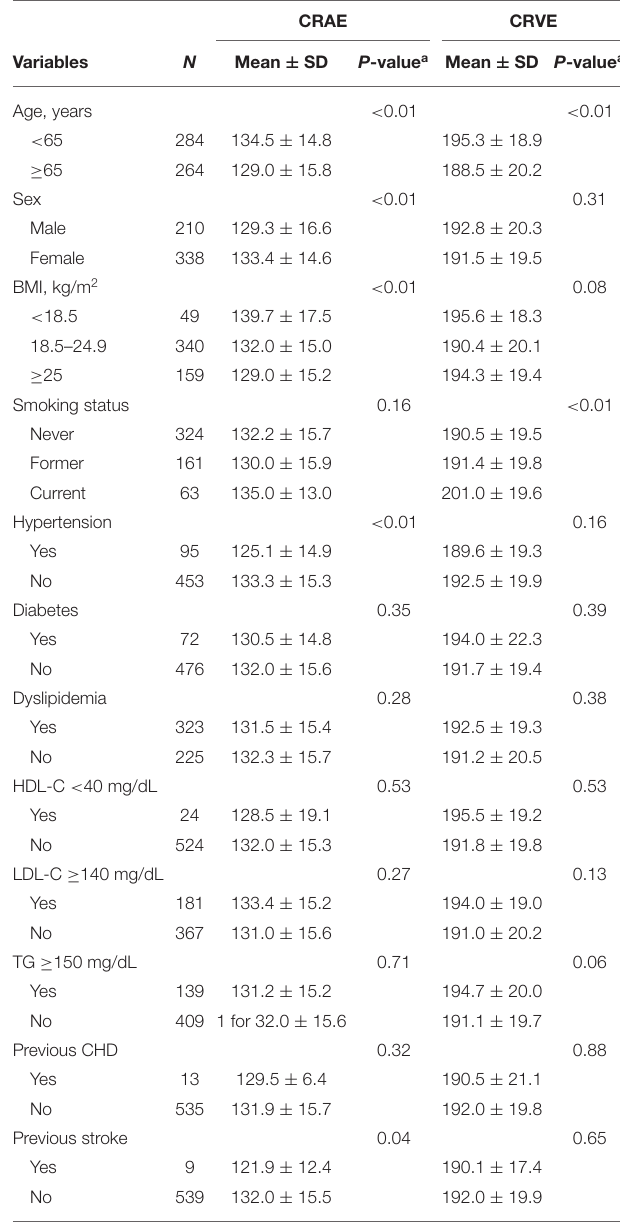
TABLE 1 | Demographic characteristics of study participants a . Characteristics